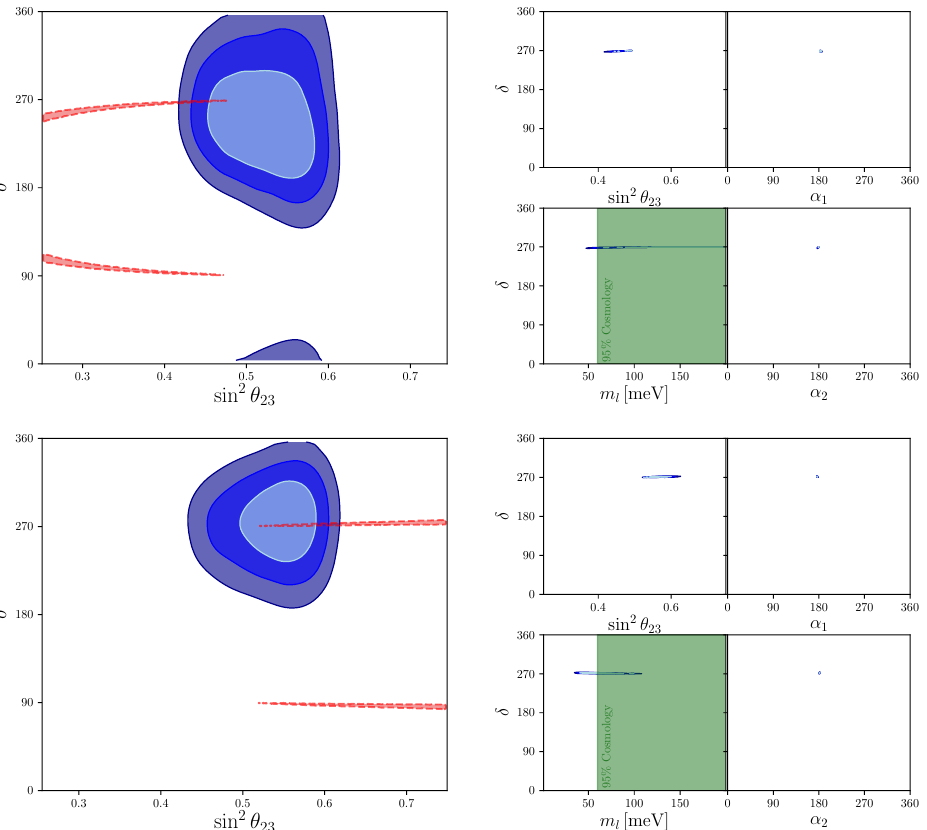
Figure 2 . Same as (cid:12)gure 1 for the B 1 texture. Upper panels for NO and lower ones for IO . In the (cid:14) - m ‘ plot we also present, for comparison, the bound on the lightest neutrino mass obtained from Cosmology (we use m ‘ < 60 meV [45]).